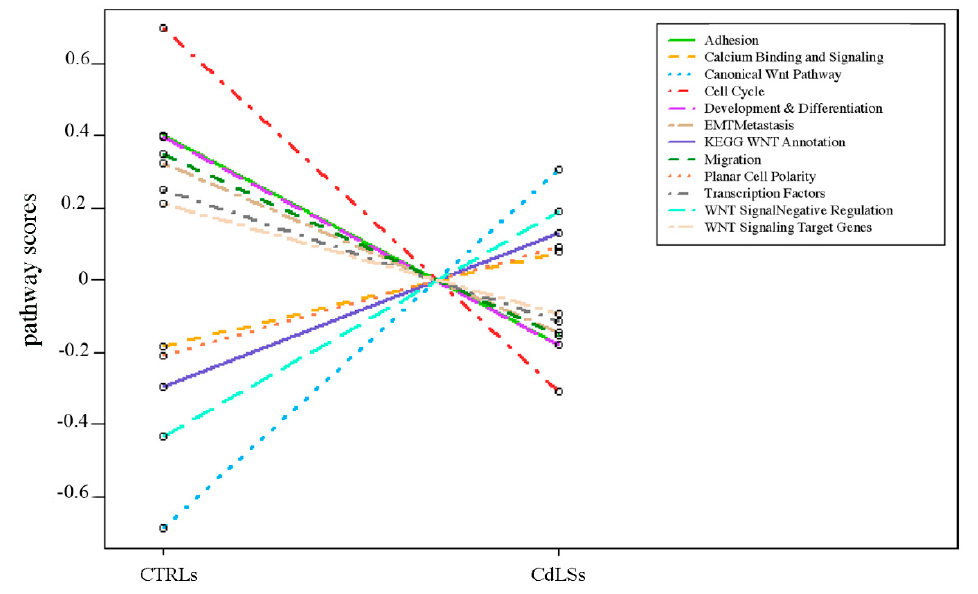
Figure 6. Trend plot of pathway scores vs. sample types (CTRLs and CdLSs). Pathway enrichment analysis was performed by nSolver software (figure rendered by Pathview, nSolver Advanced Analysis Software